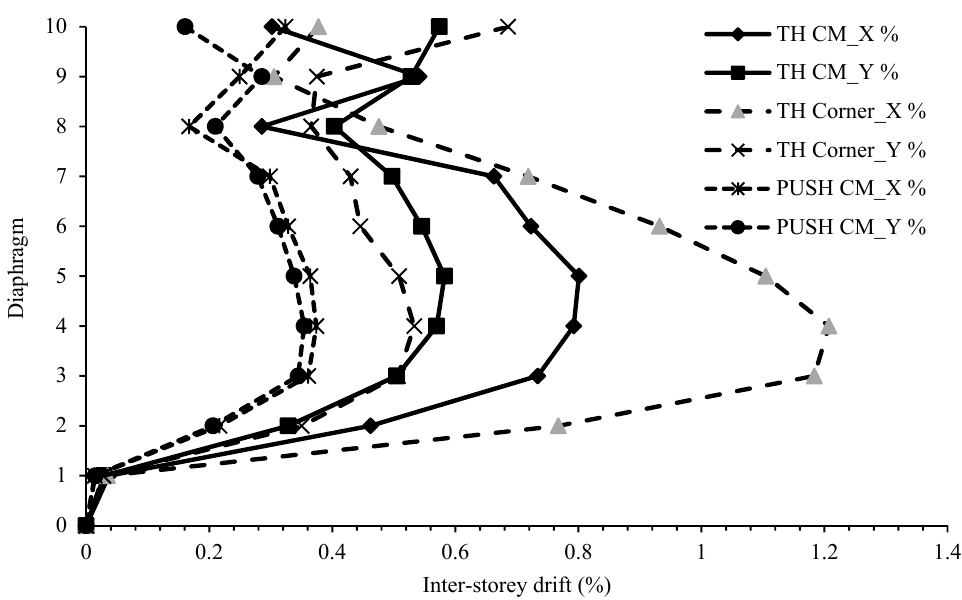
Figure 9. Inter ‐ storey drift ratio for the 0.16 g PGA input. In figure, TH indicates the time history analysis and PUSH indicates the pushover analyses conducted in both x ‐ and y ‐ directions.